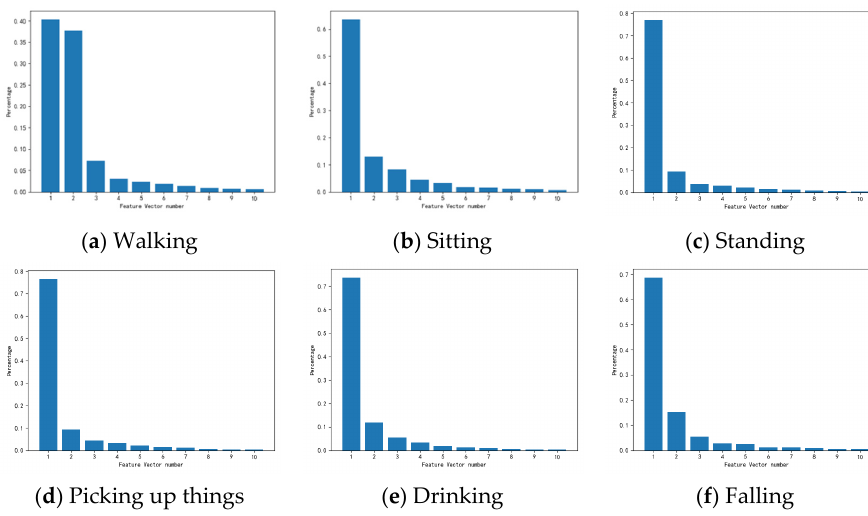
Figure 5. Contribution rates of the first 10 components of different activities.